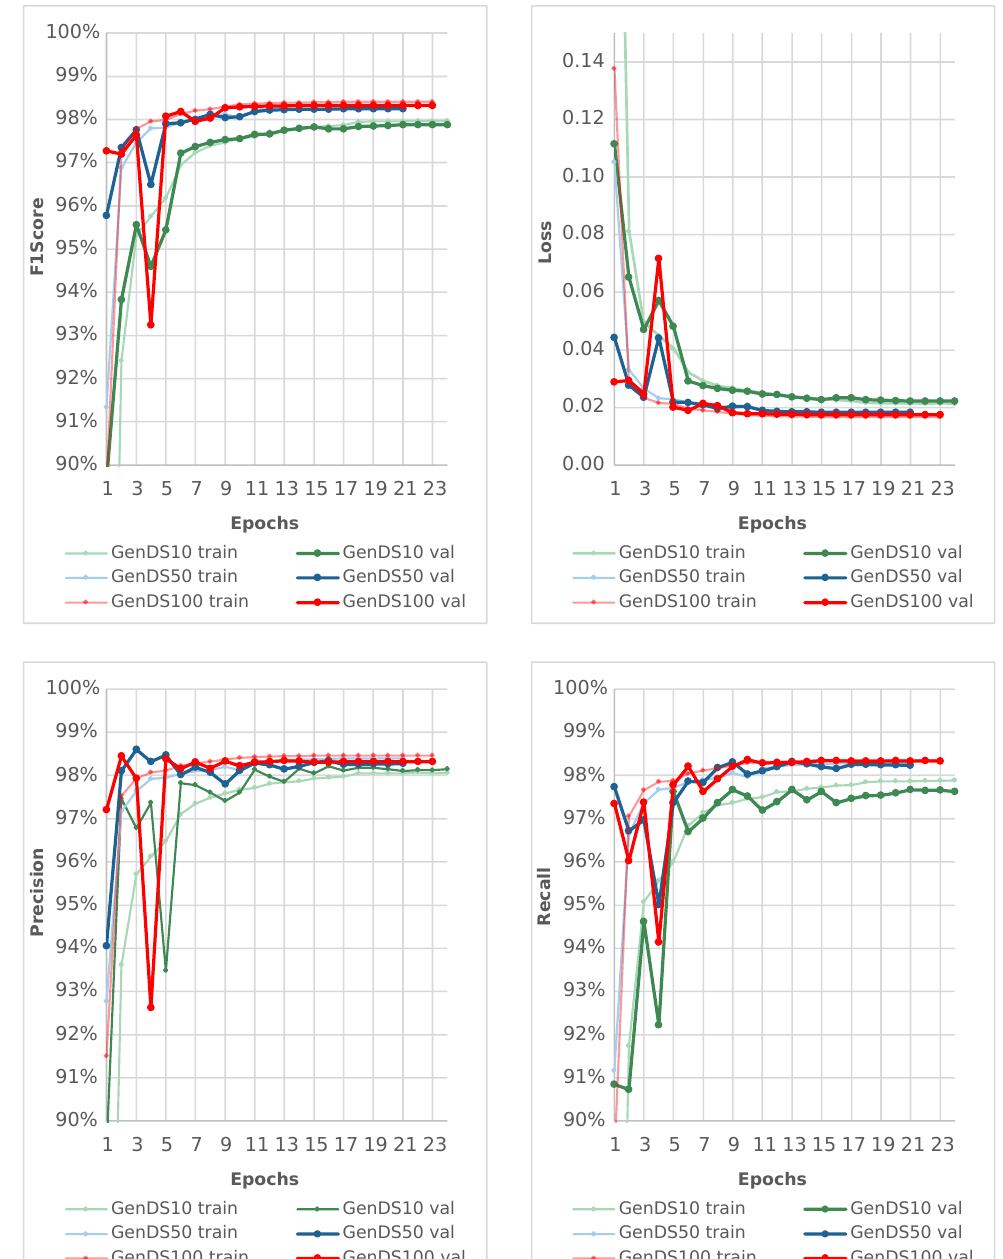
Figure 5. Training and validation performance in training stage 1 with generic training data. When comparing the curves for precision and recall (Figure 6), it can be observed that the baseline model shows the roughest curves with the biggest changes in the first five epochs, and even afterwards, the curves remain unstable and show the biggest changes from one epoch to another. In contrary, the curves of pre-trained models (S2Mod10, S2Mod50 and S2Mod100) are smother and converge faster. The fastest convergence and the smoothest learning curve were observed for the S2Mod100, the model which was trained with the highest number of augmented samples per stem in the first training